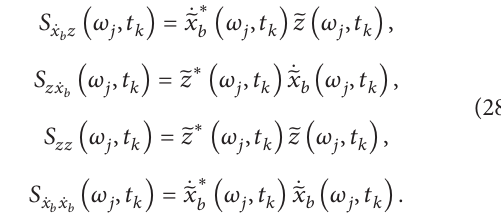
Figure 3: Time varying PSD function of sigma-oscillatory process model for Orion Boulevard 1971 earthquake ground